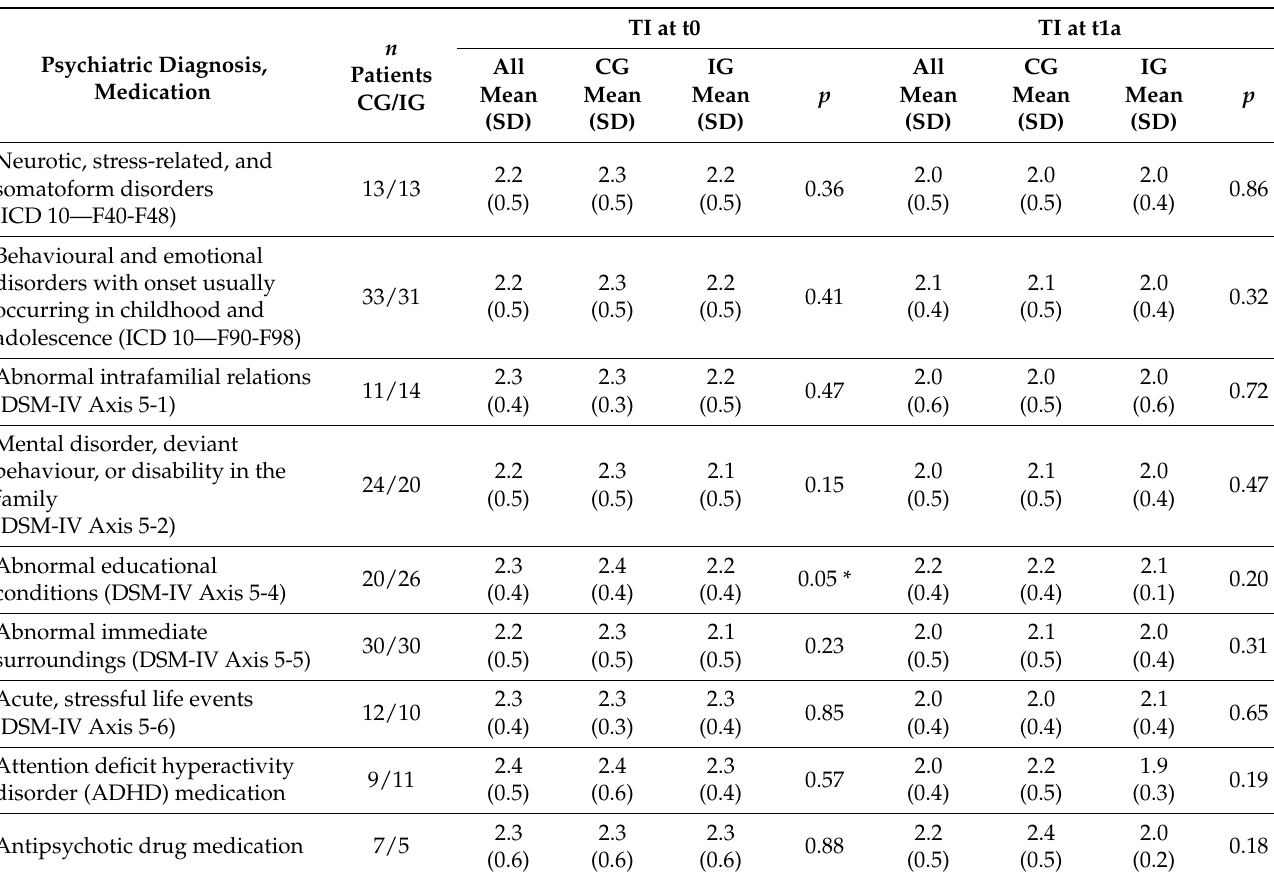
Table 4. Dental plaque in child and adolescent psychiatric in-patients (IG vs. CG) at the beginning (t0) and the end of hospitalization (t1a) in different mental disorder groups.